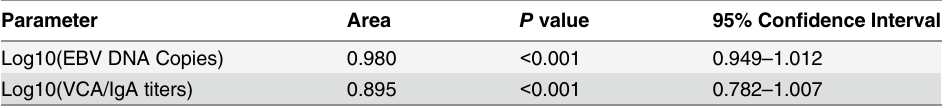
Table 7. Area under the operating characteristics